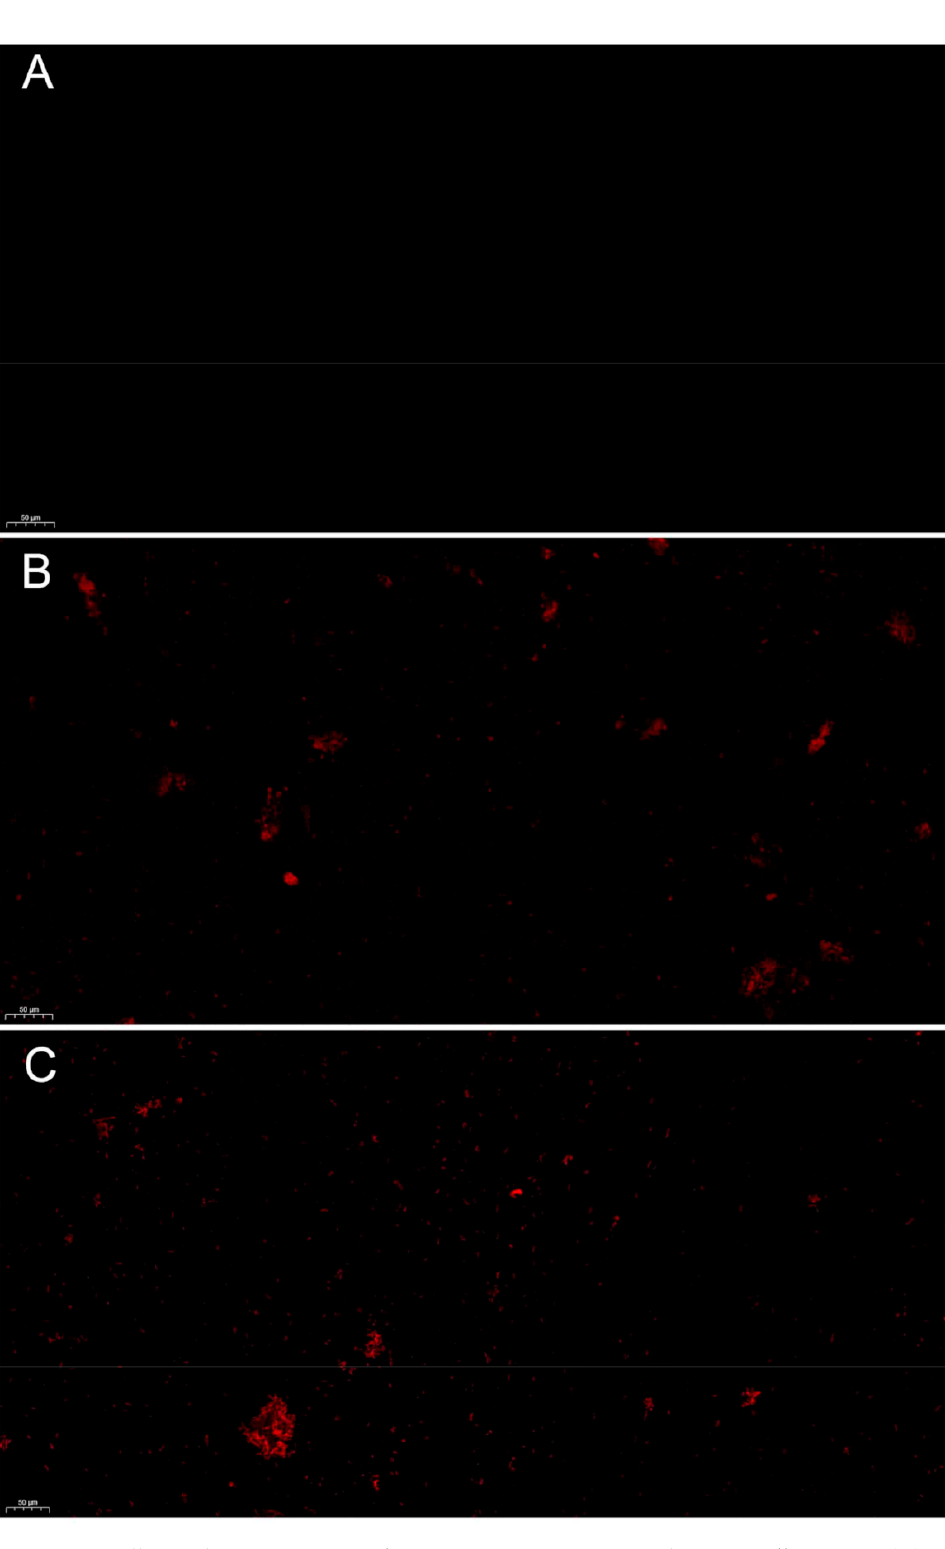
Figure 9. Cell membrane integrity of HBA against A. avenae subsp. citrulli . Note: ( A ): CK; ( B ): 125 µ g/mL; ( C ): 250 µ g/mL. 2.10. HBA on Pyruvate Level in A. avenae subsp.